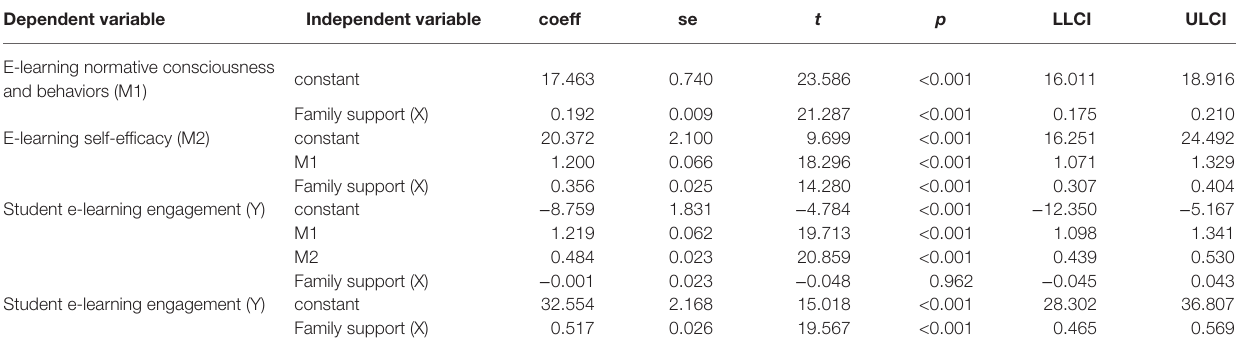
TABLE 4 | Direct effect results of mediation analysis. Dependent variable